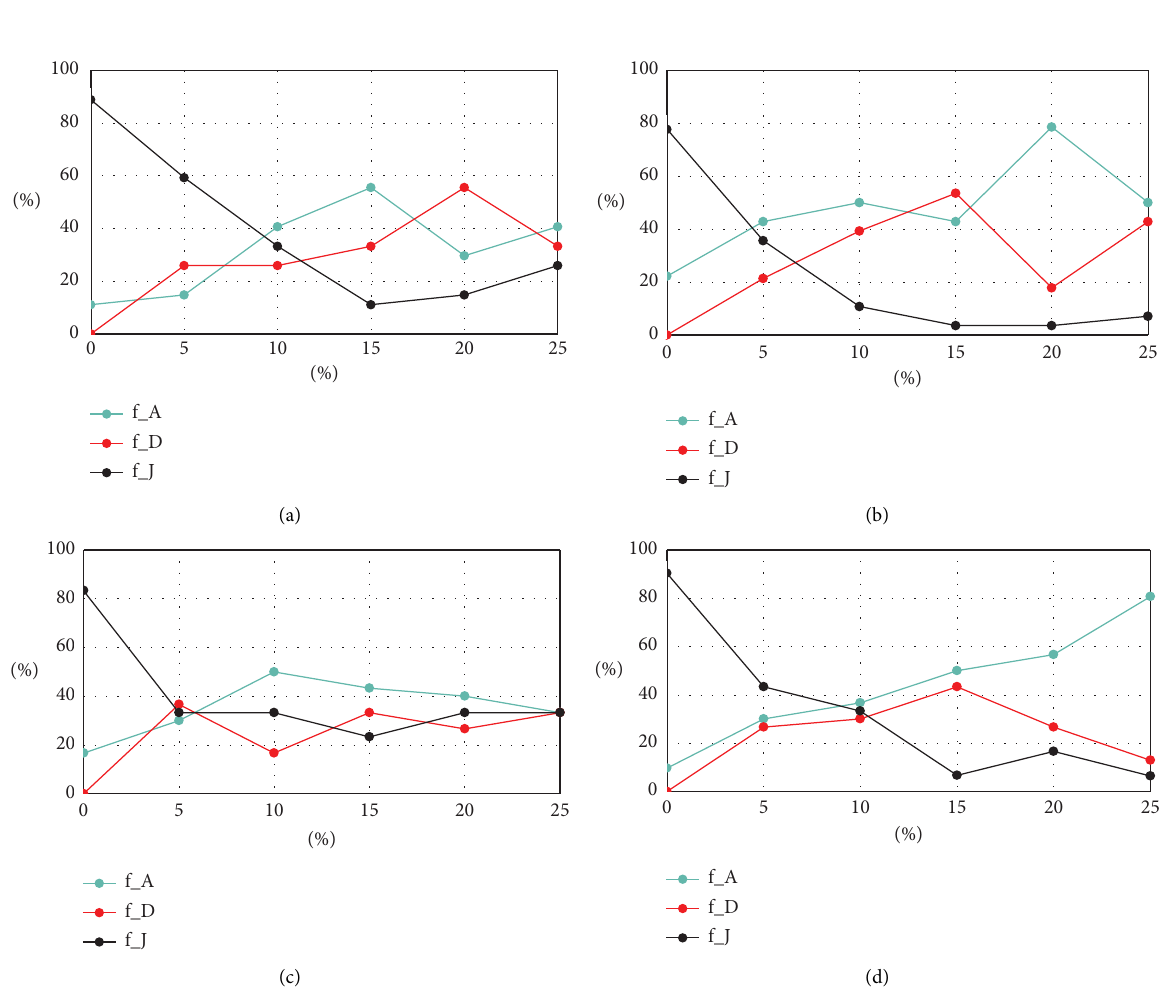
Figure 12: f , f f A D and J evolution, from 0% to 25% of tolerance factor study